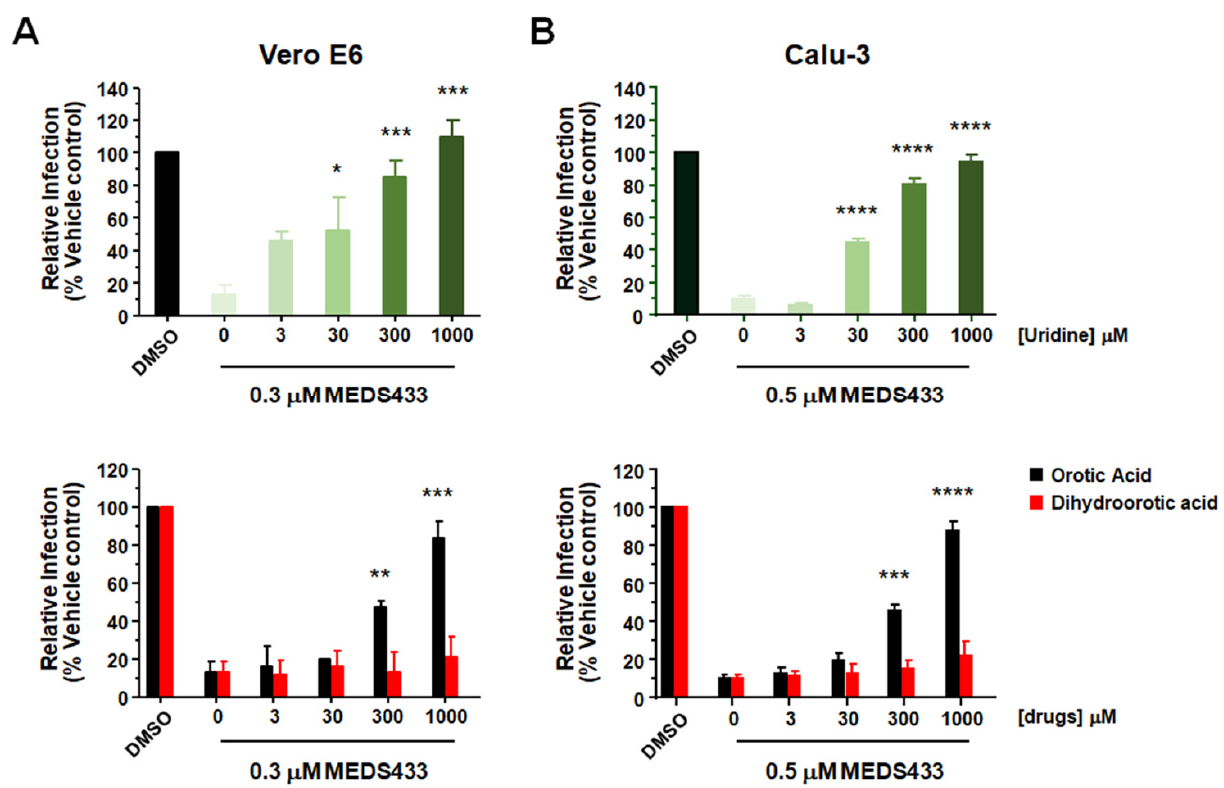
Figure 5. Uridine or orotic acid supplementation counteracts the anti-SARS-CoV-2 activity of MEDS433. Vero E6 ( A ) or Calu-3 ( B ) cells were treated with vehicle (DMSO), or 0.3 µ M of MEDS433 for Vero E6 cells, or 0.5 µ M of MEDS433 for Calu-3 cells in the absence or presence of increasing concentrations of uridine (upper panel), orotic acid or dihydroorotic acid (lower panel) before and during infection with SARS-CoV-2 (50 PFU/well for Vero E6 cells and 100 PFU for Calu-3 cells). At 48 h p.i. cell supernatants were harvested and titrated on Vero E6 cells. Plaque counts for each drug concentration were expressed as a percent of the mean count of the control cultures treated with DMSO. The data shown represent means ± SD of three independent experiments performed in triplicate. Statistical significance was calculated by a one-way ANOVA followed by Dunnett’s multiple comparison test, **** ( p) < 0.00001), *** ( p < 0.0001), ** ( p < 0.001) and * ( p < 0.05) compared to the calibrator sample (MEDS433